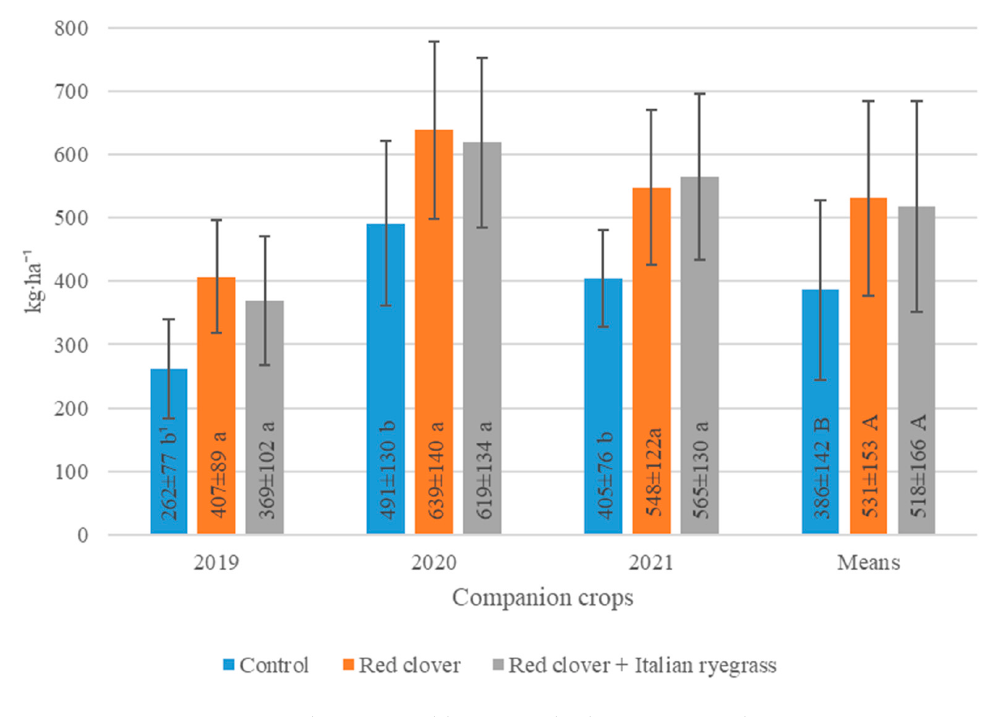
Figure 3. Total protein yield in spring barley grain according to companion crops from 2019–2021, kg · ha − 1 . 1 Values in years for the interaction followed by the same small letter (a, b) do not differ significantly at p < 0.05, means for the companion crops by the same capital letter (A, B) do not differ significantly at p < 0.05. ±, standard deviation.